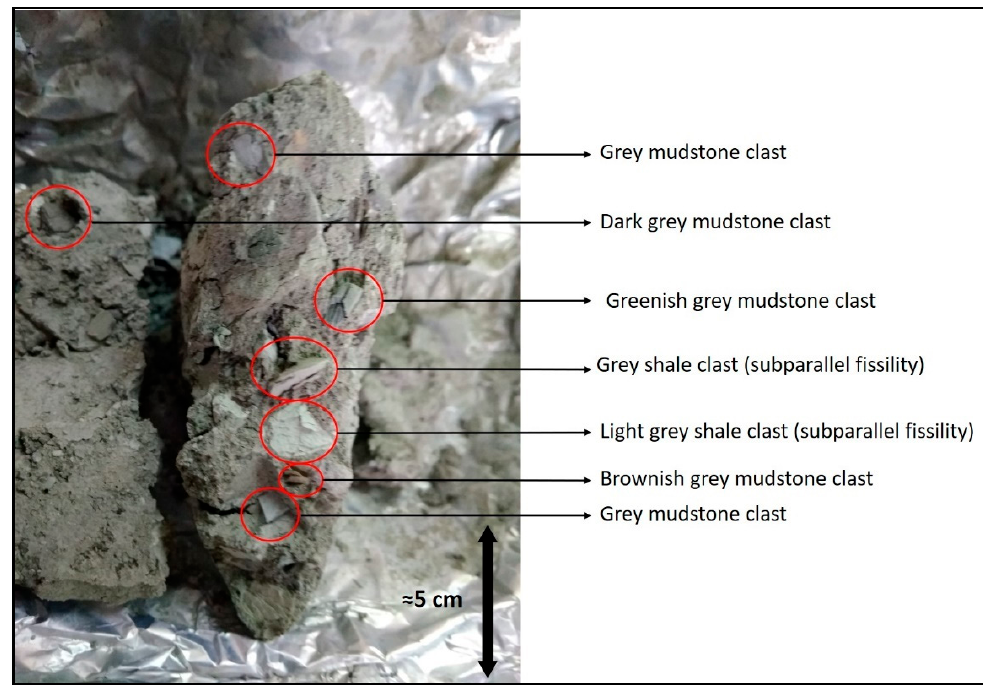
Figure 4. Image of a representative mud breccia facies from the Olimpi mud volcano field (LEV5GC core from the Moscow MV).